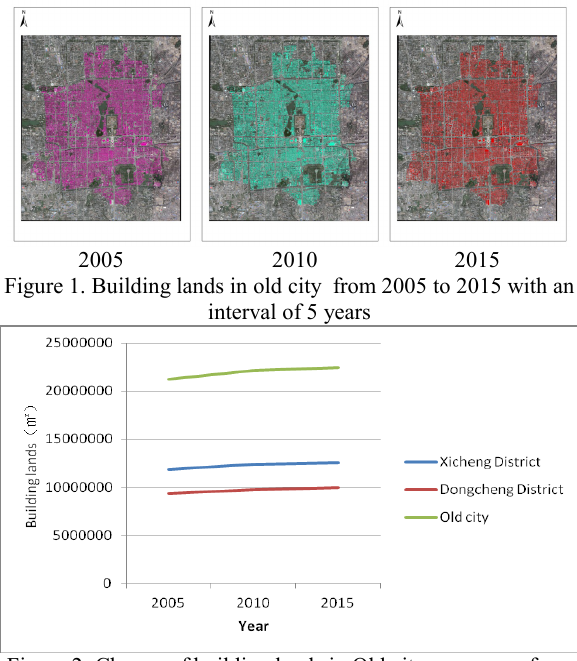
Figure 2. Change of building lands in Old city over years from